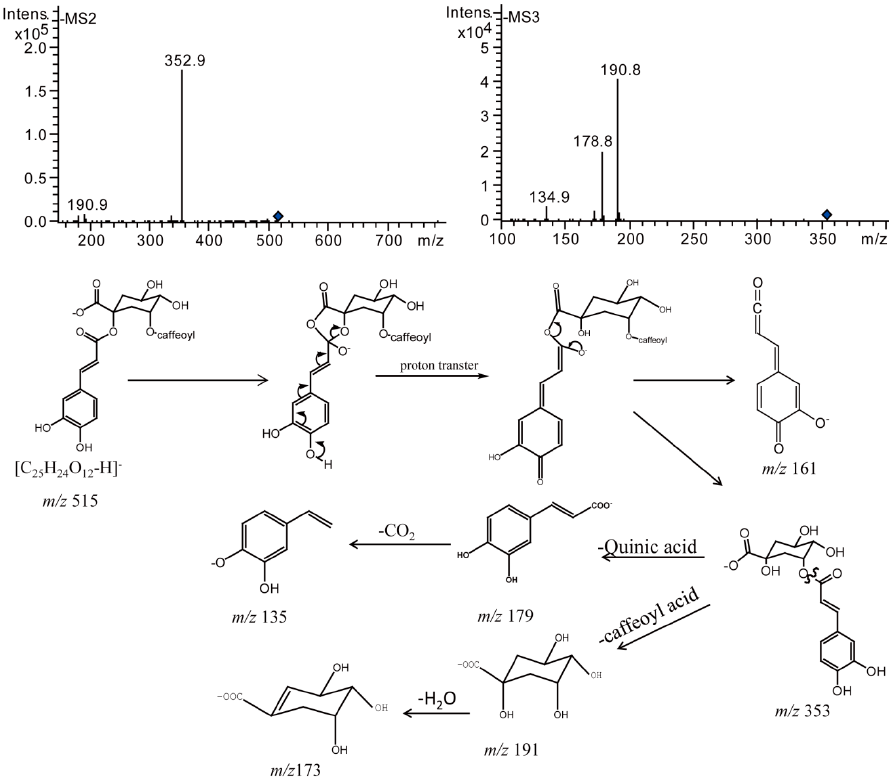
Figure 11. Negative MS n spectra and proposed fragmentation patterns of compound 10 .